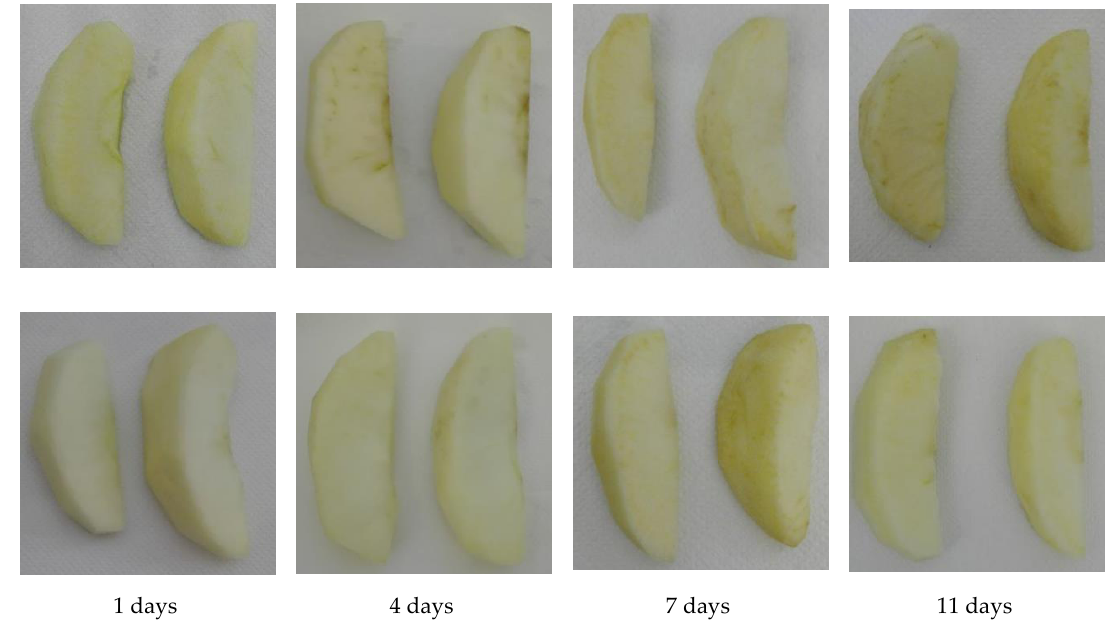
Figure 3. Color change of minimally processed apples during storage for 14 days at 5 °C. Control Figure3. Colorchangeofminimallyprocessedapplesduringstoragefor14daysat5 ◦ C.Controlsamples samples (high); coated sample (bottom). ( high ); coated sample ( bottom